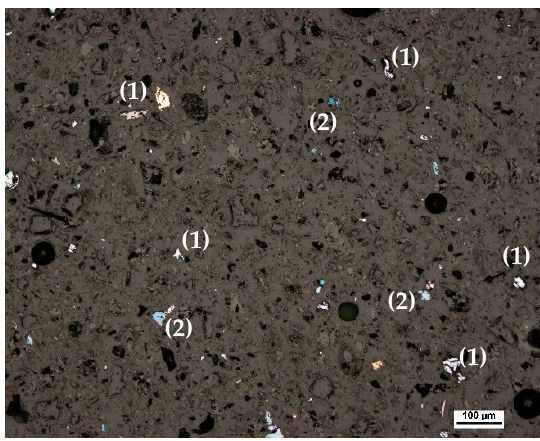
Figure 8. F sp = 4.5 N/mm 2 : liberated particles of chalcocite (1) and covellite (2).